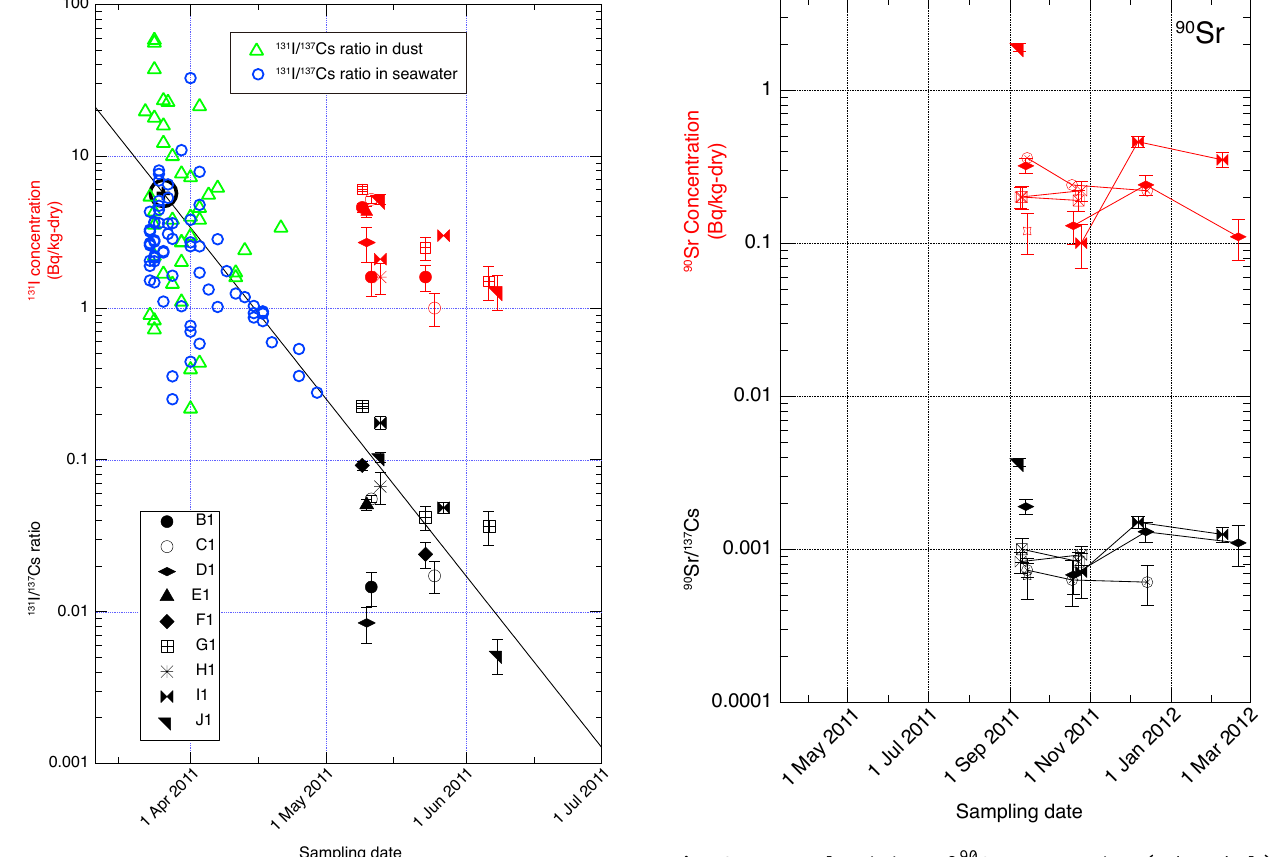
Fig. 12. Temporal variations of 90 Sr concentrations (red symbols) and 90 Sr/ 137 Cs ratios (black symbols) in the sediments. Values be- low the detection limit are not shown. See Fig. 13 for a key to the